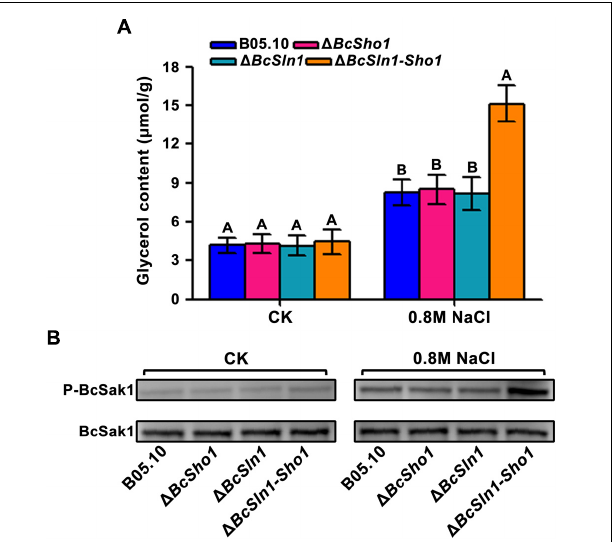
FIGURE 7 | Glycerol content and BcSak1 phosphorylation of B05.10, (cid:49) BcSho1 , (cid:49) BcSln1 , and (cid:49) BcSln1-Sho1 . (A) The amounts of glycerol (per g mycelial dry weight) produced by each strain in YEPD medium amended with 0.8 M NaCl. The cultures without any treatment were used as control (CK). Bars represent standard errors from three replications. Values on the bars followed by the same letter are not significantly different at P = 0.05. (B) The BcSak1 and phosphorylated BcSak1 proteins were detected using the yeast anti-Hog1p (C-terminal anti-Hog1) and phosphorylated p38 (Thr180/Tyr182) antibodies,